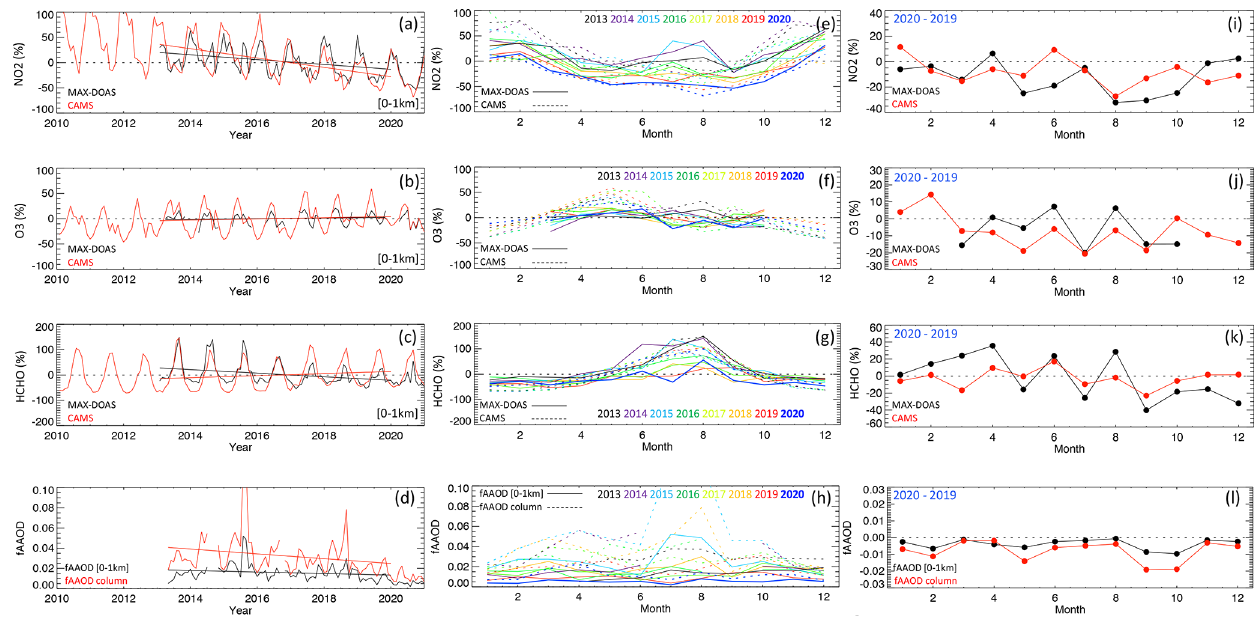
Figure 4. (a–d) Monthly time series of NO 2 (a) , O 3 (b) , and HCHO (c) partial tropospheric column ( < 1km) as recorded by the MAX- DOAS system and estimated by CAMS at Chiba University. (e–h) Seasonal monthly changes in MAX-DOAS observations and CAMS estimates of NO 2 (e) , O 3 (f) , and HCHO (g) . (i–l) Differences (2020 minus 2019) in MAX-DOAS observations and CAMS estimates for NO 2 (i) , O 3 (j) , and HCHO (k) . Results are shown as percentage changes with respect to the 2013–2019 average (left and central panels) and 2019 (right panels). (d, h, l) Changes as described above but for fine-mode light-absorbing aerosols, i.e., fAAOD and fAAOD